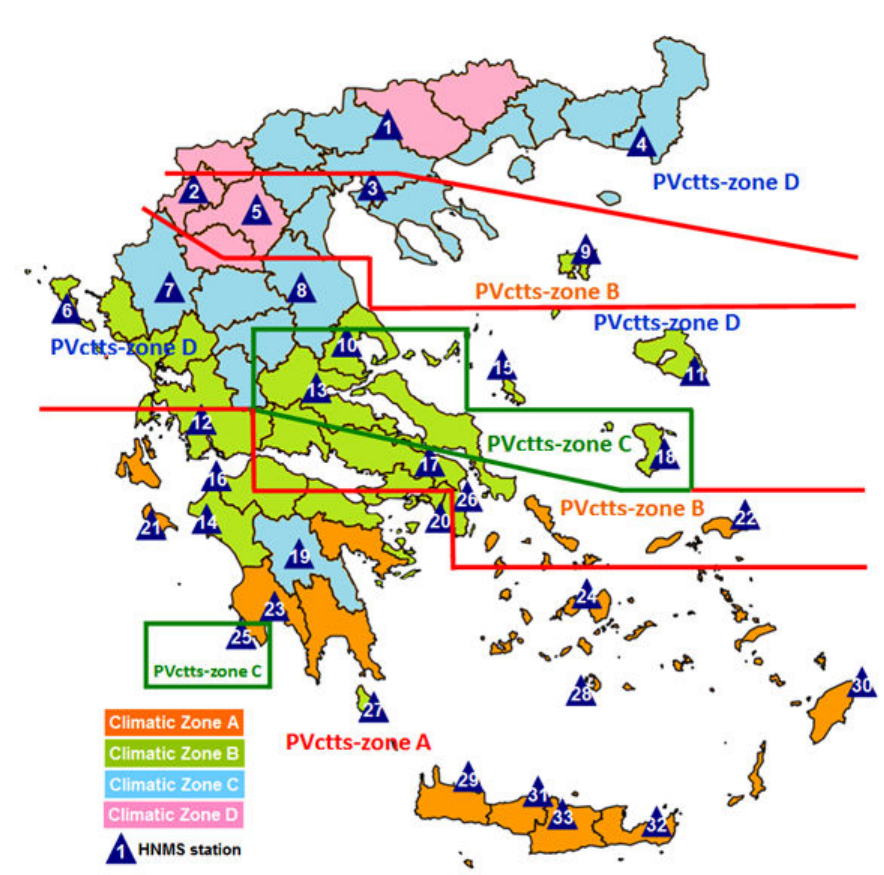
Figure 14. Division of Greece into four PV ctts zones for the operation of solar flat-plate convertors with optimal tilt angles to the south.